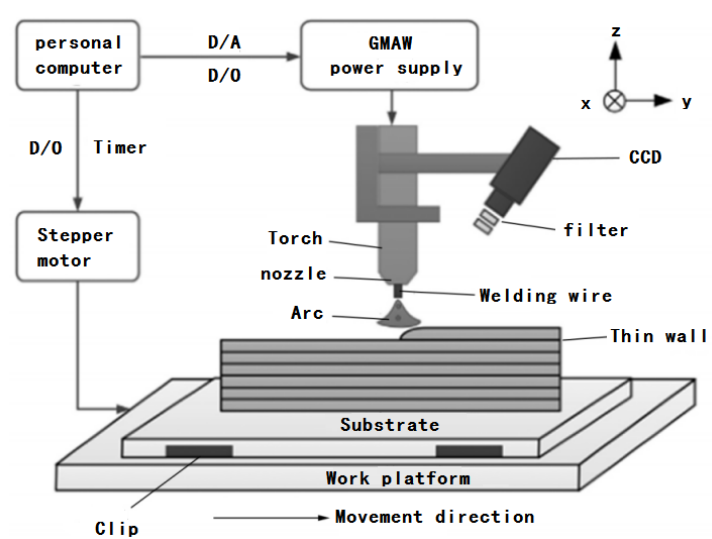
Figure 2. Gas metal arc welding (GMAW) additive manufacturing schematic diagram [9].